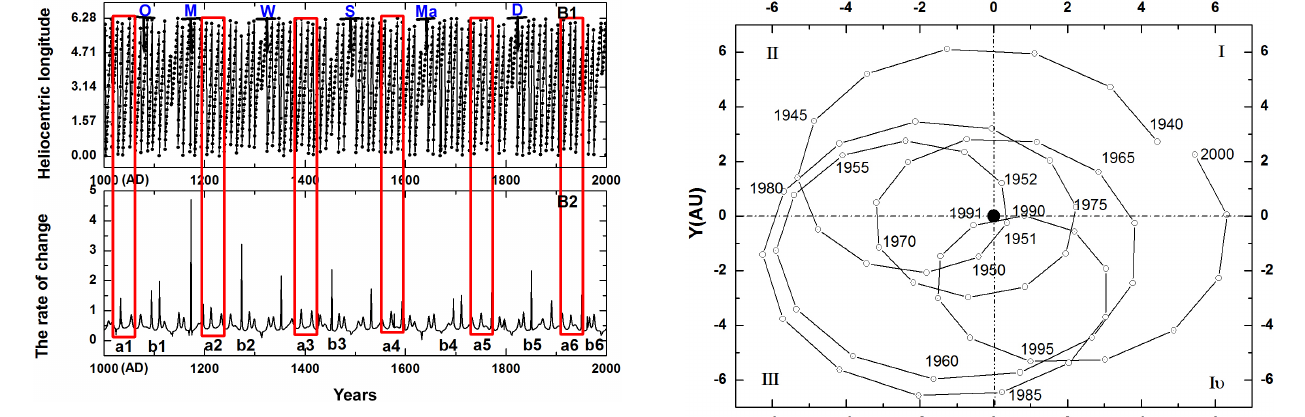
Figure 3. Planetary system heliocentric longitude and change rate of the planetary system’s mass center ( P ) orbiting the fixed point of the Sun ( S ). Figure 4. Heliocentric longitude of the planetary system’s mass